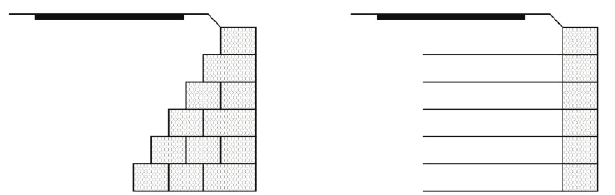
Fig. 1. Comparison of gabion structures: massive (on the left) and with reinforced fill (on the right)